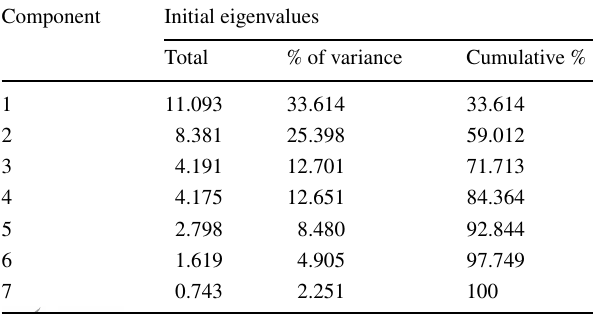
Table 4 Initial PCA for wet season